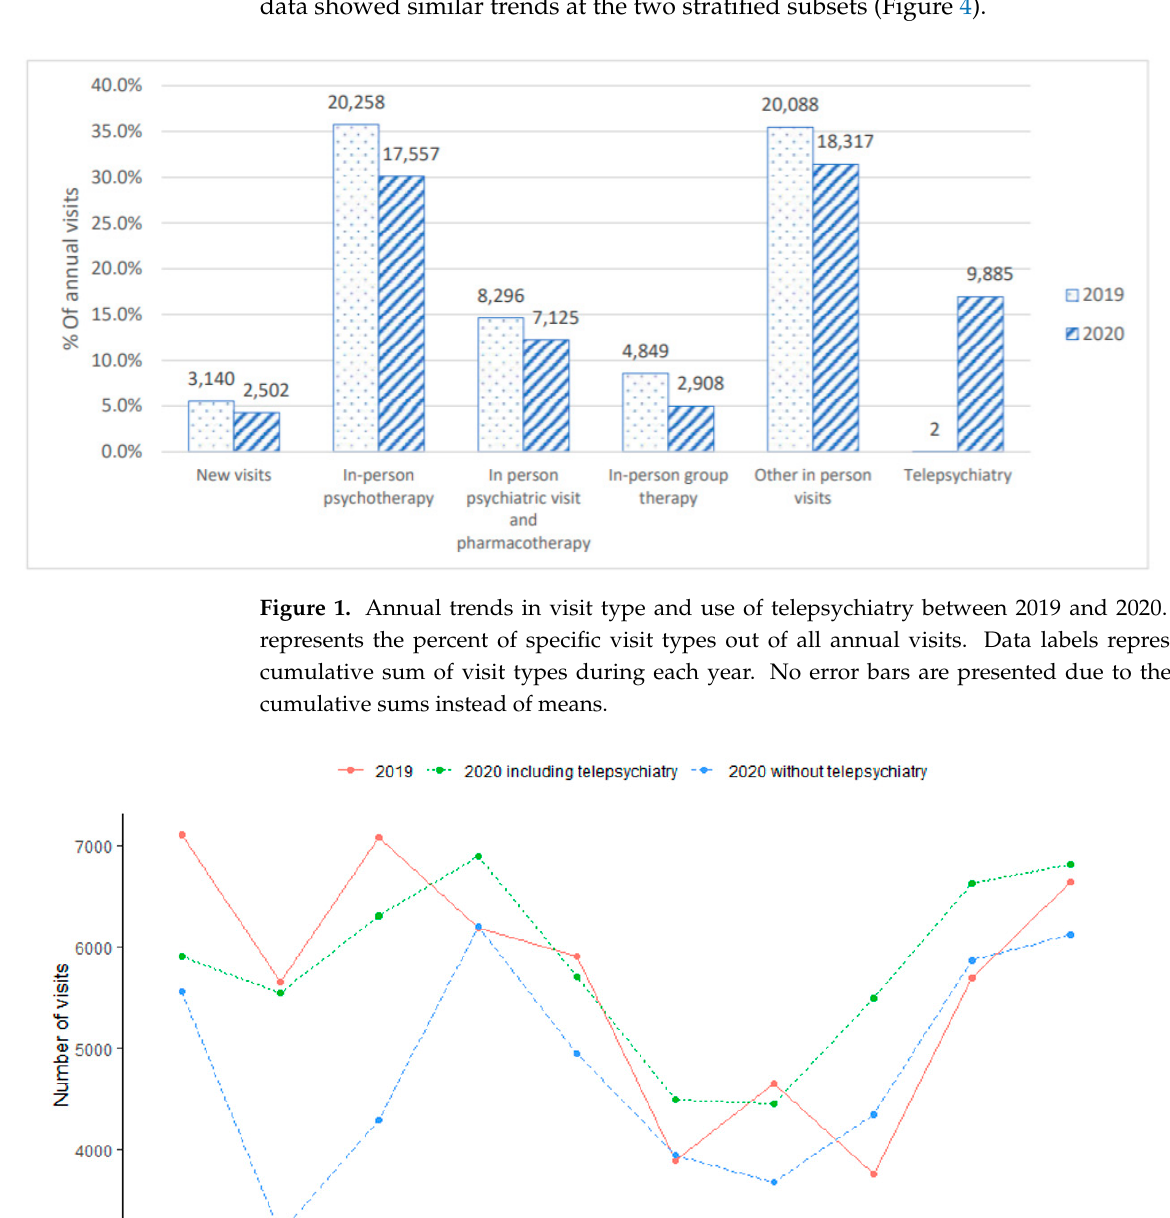
Figure 3. Monthly visits during the lockdown and opening periods in 2019 as compared to 2020. Bars relate to standard deviation. * p < 0.05, *** p < 0.001. Figure 4. Monthly visits to psychiatric hospitals and general hospitals in 2019 as compared to 2020. Bars relate to standard deviation. ** p < 0.01.